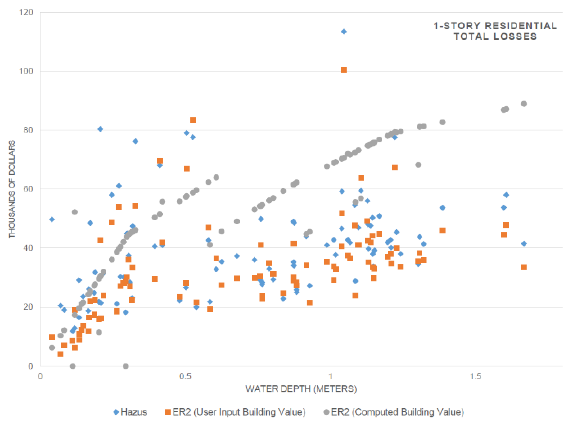
Figure 9. Total Damages versus water depth for Hazus, ER 2 using user input building value and ER 2 using computed building value.